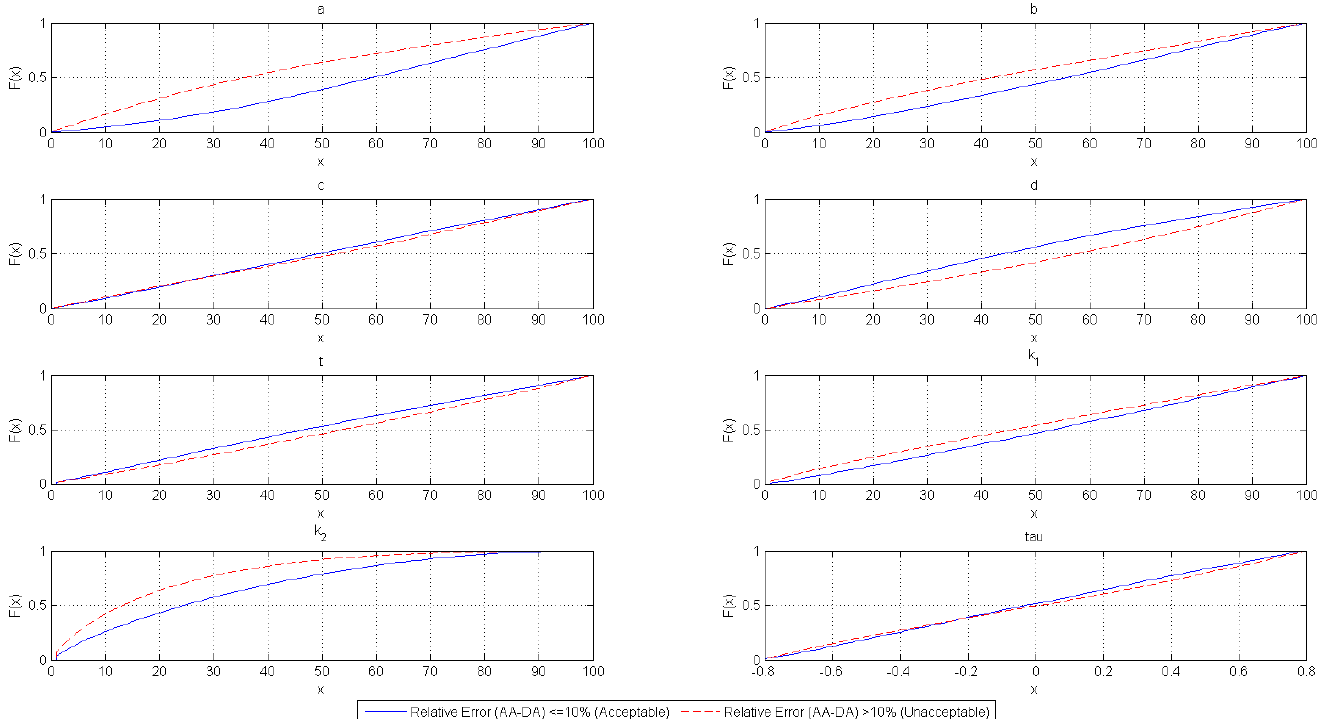
Figure 1. Observed CDF of individual parameters in AA − DA